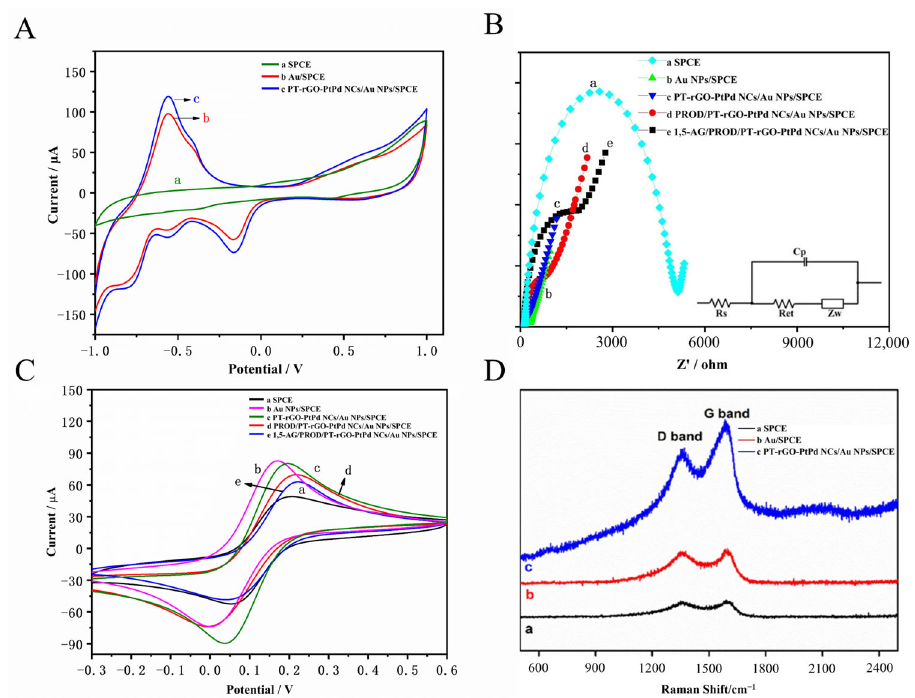
Figure 3. ( A ) The CV curves of (a) SPCE, (b) Au NPs/SPCE, and (c) PT-rGO-PtPd NCs/Au NPs/SPCE in PBS solution (0.1 mol/L, pH 7.0) in the presence of 100.0 µmol/L H 2 O 2 . ( B ) EIS and ( C ) CV curves of di ff erent electrodes ((a) SPCE, (b) Au NPs/SPCE, (c) PT-rGO-PtPd NCs/Au NPs/SPCE, (d) PROD/PT-rGO-PtPd NCs/Au NPs/SPCE, and (e) 1,5-AG/PROD/PT-rGO-PtPd NCs/Au NPs/SPCE) in PBS solution (0.1 mol/L, pH 7.0) containing 5.0 mmol/L K 3 Fe (CN) 6 /K 4 Fe (CN) 6 and 0.1 mol/L KCl. ( D ) The Raman spectrum of di ff erent modi fi ed electrodes ((a) bare SPCE, (b) Au NPs/SPCE, and (c) PT-rGO-PtPd NCs/Au NP/SPCE).